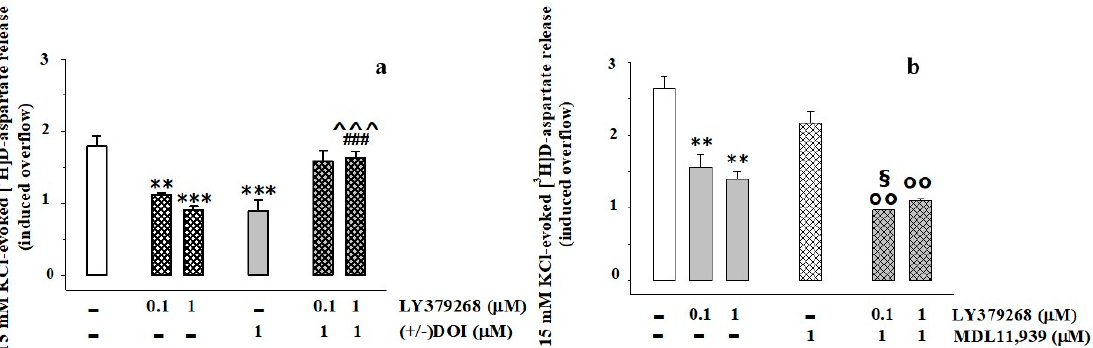
Figure 2. Presynaptic release-regulating mGlu2/3 autoreceptors and 5-HT 2A heteroreceptors func- tionally crosstalk in synaptosomes from the prefrontal cortex of adult rats. ( a ) Effects of ( ± ) DOI (1 µ M) and of LY379268 (0.1–1 µ M) alone or concomitantly added on the 15 mM KCl-evoked [ 3 H]D-asp